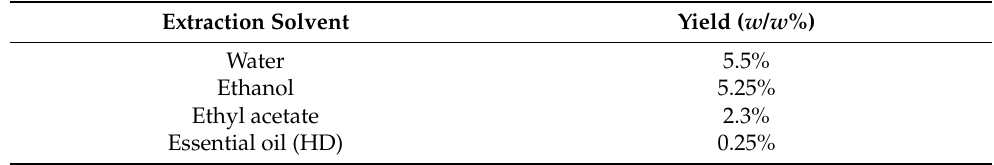
Table 1. Percentage yields obtained by extraction of 100g of A. citrodora using different extraction solvents and